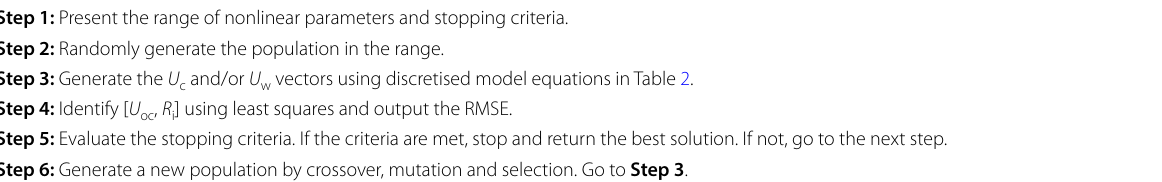
Table 3 The main procedures of the parameter identification method Step 1: Present the range of nonlinear parameters and stopping criteria. Step 2: Randomly generate the population in the range.